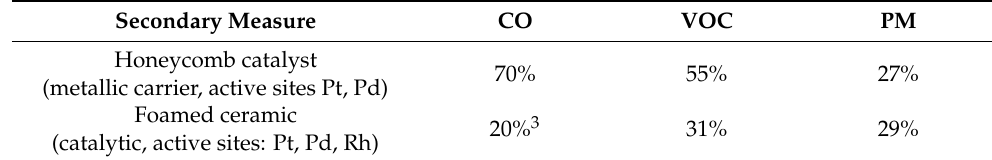
Table 4. Results of conversion efficiencies of experimental lab tests using an integrated honeycomb catalyst or catalytic foamed ceramic without any bypass (Equation (3))